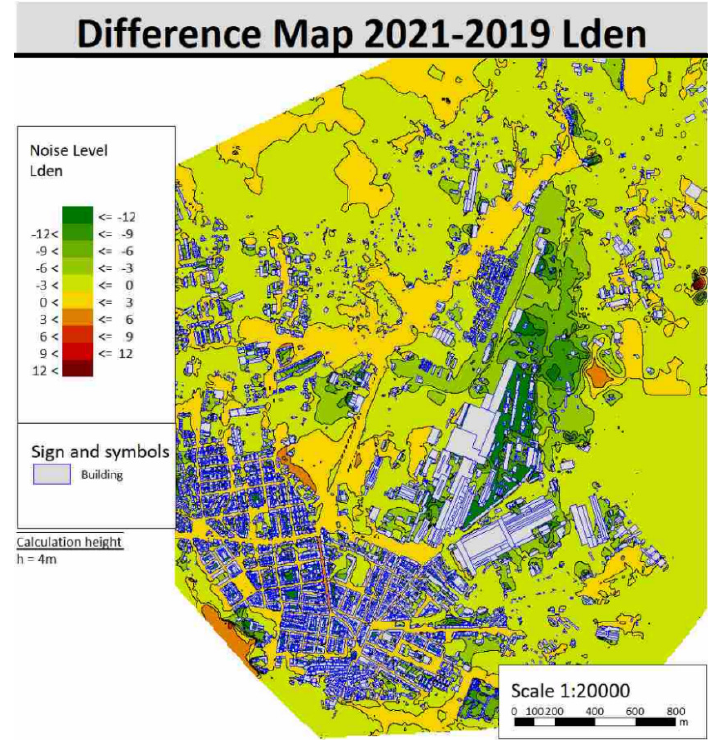
Figure 15. Difference maps of noise for 2021–2019 with L den indicator.